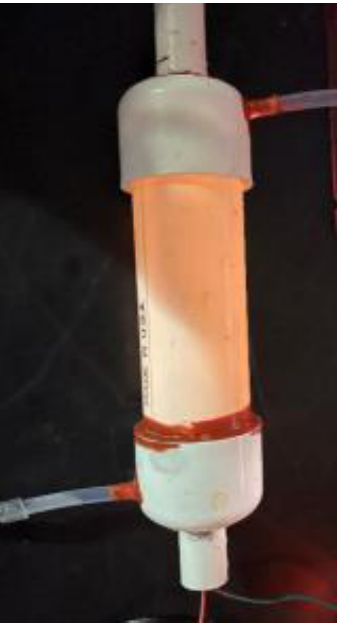
Figure 5. Photograph of one of four UV LED photocatalytic devices used in this study. The light sources were strip UV LEDs from Waveform Lighting. The strips were adhered vertically to the outside surface of the inside tube so that they were facing outward. The emission spectrum of the UV LEDs center at a wavelength near 365 nm [74]. The light intensity from the strip LEDs was characterized as a function of distance away from the strip using an Omega light meter (HHUV254SD Model) with a UVA sensor, and the resulting data are shown graphically in Figure 6. In the photocatalytic device, the distance between the UV LEDs and the photocatalytic film was approximately 1.8 cm, so the power intensity at the photocatalyst was approximately 2 mW/cm 2 . The direct current (DC) power required for the UV LEDs in each device was approximately 6 W (12 V, 0.5